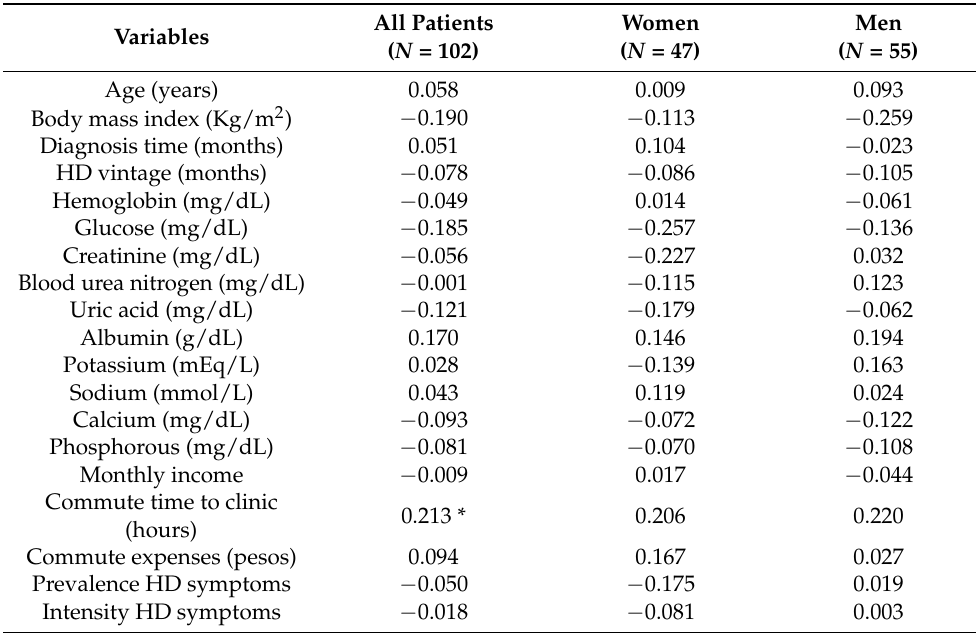
Table 5. Spearman correlation coefficients between self-care and ordinal variables. Significant correlation ( p < 0.05) is indicated with an asterisk (*).